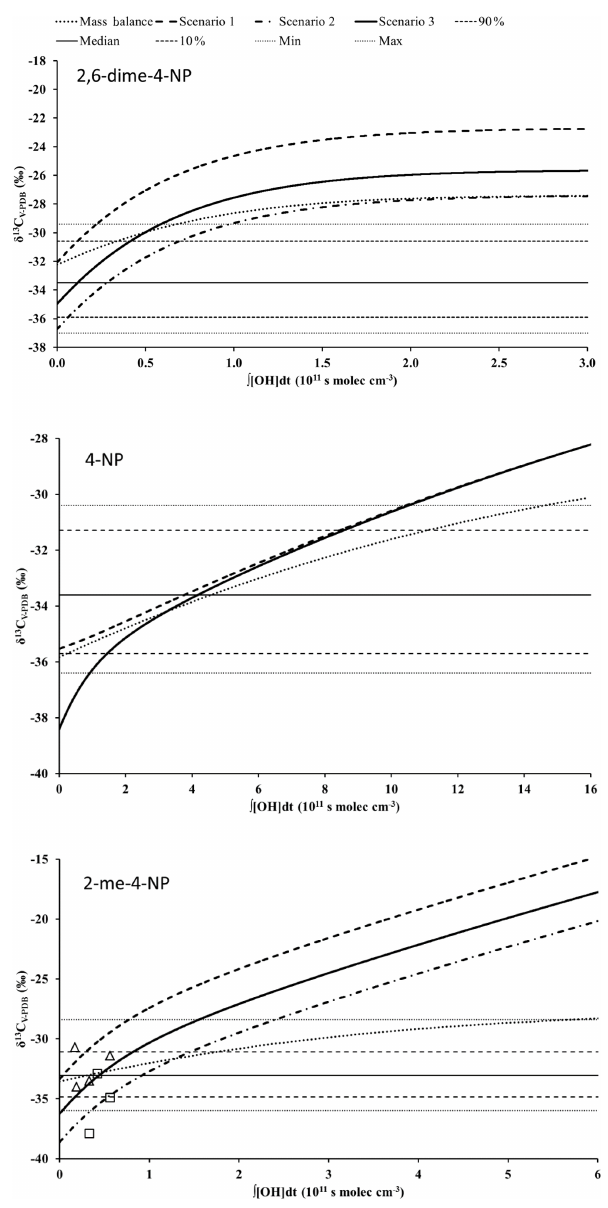
Figure 2. Dependence between the carbon isotope ratio and the PCA ( R [OH]d t ) for several nitrophenols calculated for different scenarios using a mechanistic model and mass balance. Also shown are the median, the 10th and 90th percentiles, and the lowest and highest carbon isotope ratios measured by Saccon at al. (2015) in an urban area. The triangles and squares represent the carbon iso- tope ratios of 3-methyl-4-nitrophenol and 2-methyl-4-nitrophenol, respectively, reported by Irei et al. (2015) for laboratory studies.